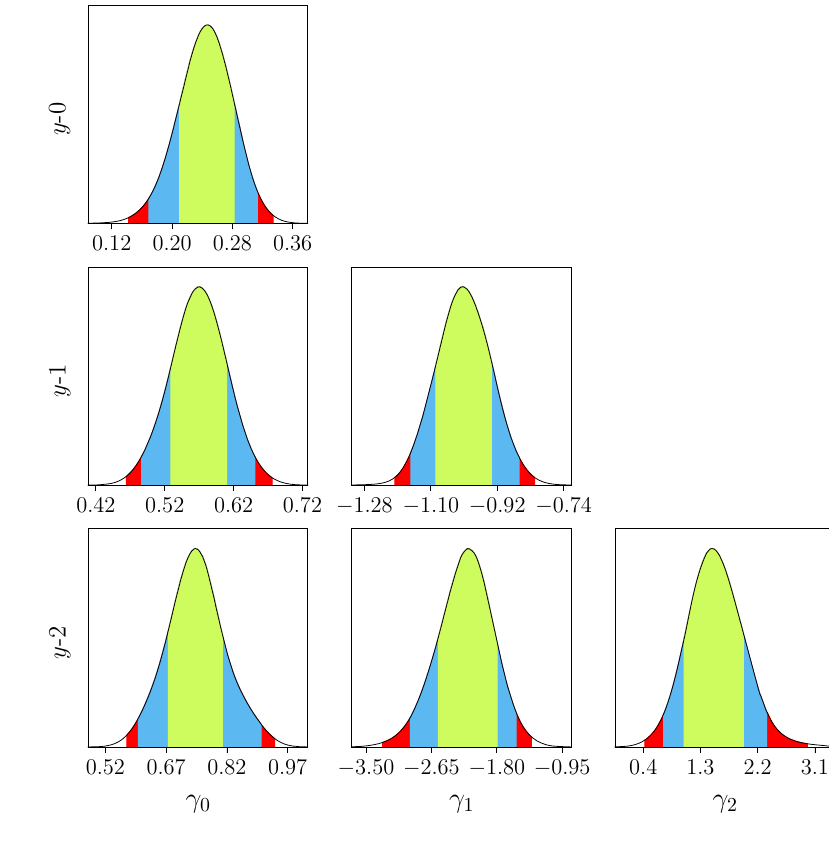
Fig. 2 The same as in Fig. 1, except for the y -0, y -1, y -2 cases. See the text and Table 3 for details